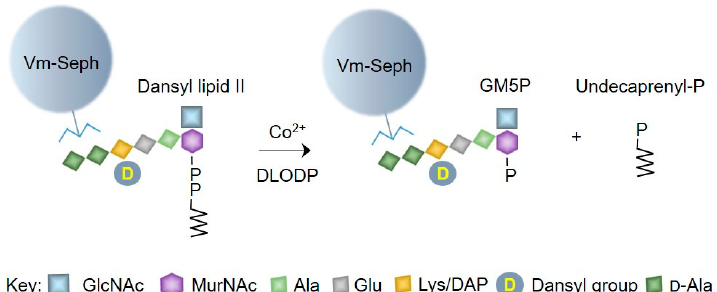
Figure 2. DLO diphosphatase (DLODP) assay strategy involving capture of lipid II and its potential hydrolysis products on vancomycin–Sepharose affinity beads. It is hypothesized that the previously